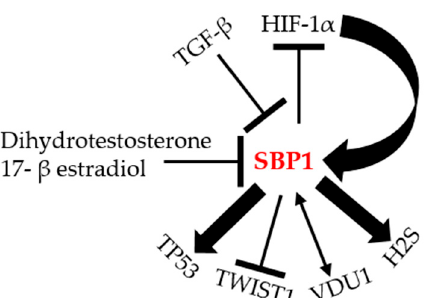
Figure 3. The molecular regulation of SBP1. Illustration of the different proteins that can potentially interact, be regulated by, or regulate SBP1 according to the literature. TGF- β : transforming growth factor beta; HIF-1 α : hypoxia-inducible factor-1 α ; H2S: hydrogen sulfide; VDU1: von Hippel–Lindau protein–interacting deubiquitinating enzyme 1; TWIST1: Twist Family BHLH Transcription Factor 1;